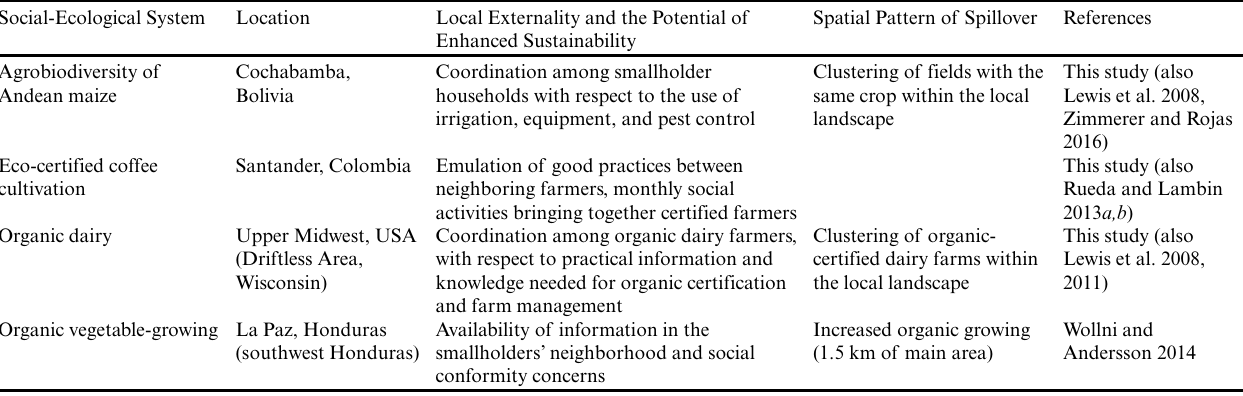
Table 4 . Systematic description of local spillovers in telecoupled smallholder social-ecological systems (SES). Social-Ecological